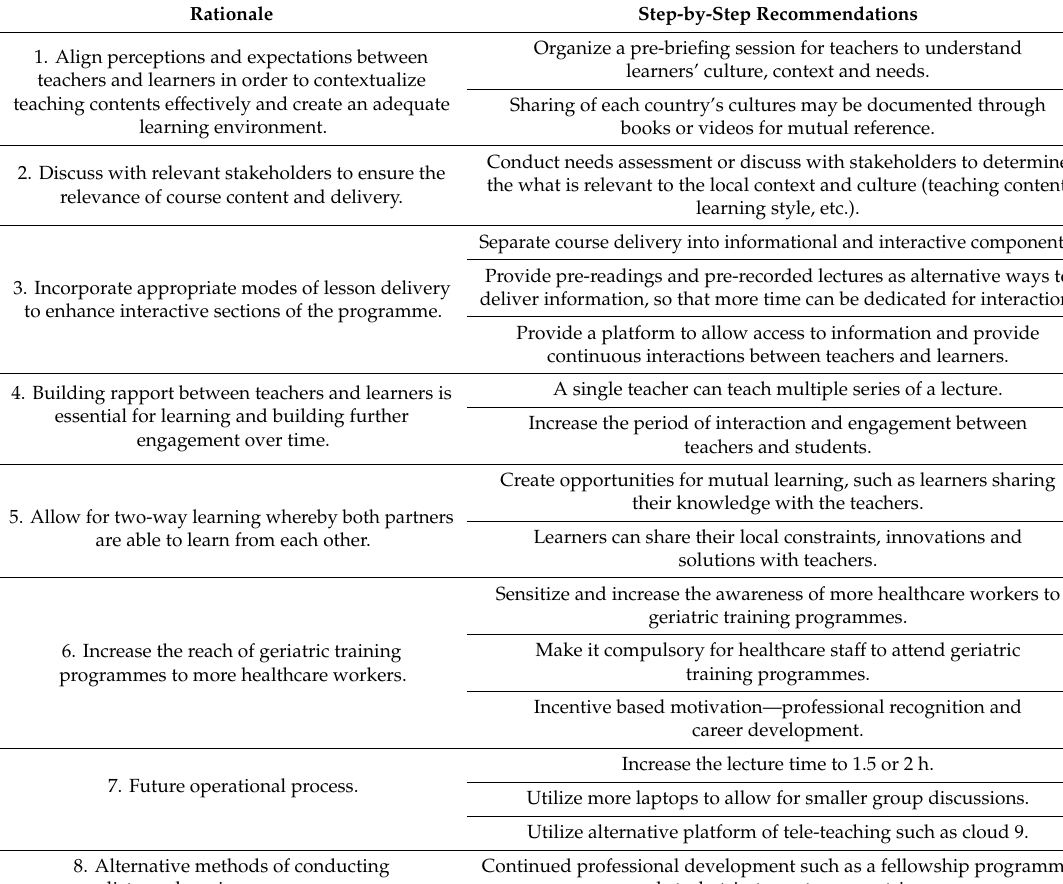
Table 2. Recommendations for future programme’s